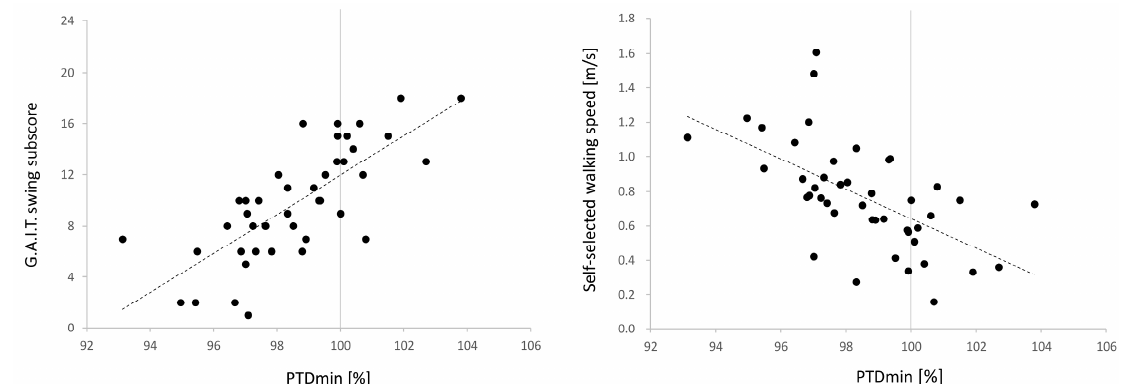
Figure 4. Correlation between PTDmin of affected side and the GAIT score during swing phase ( left ) and SSWS ( right ). The Dashed line represents the trend line on the affected